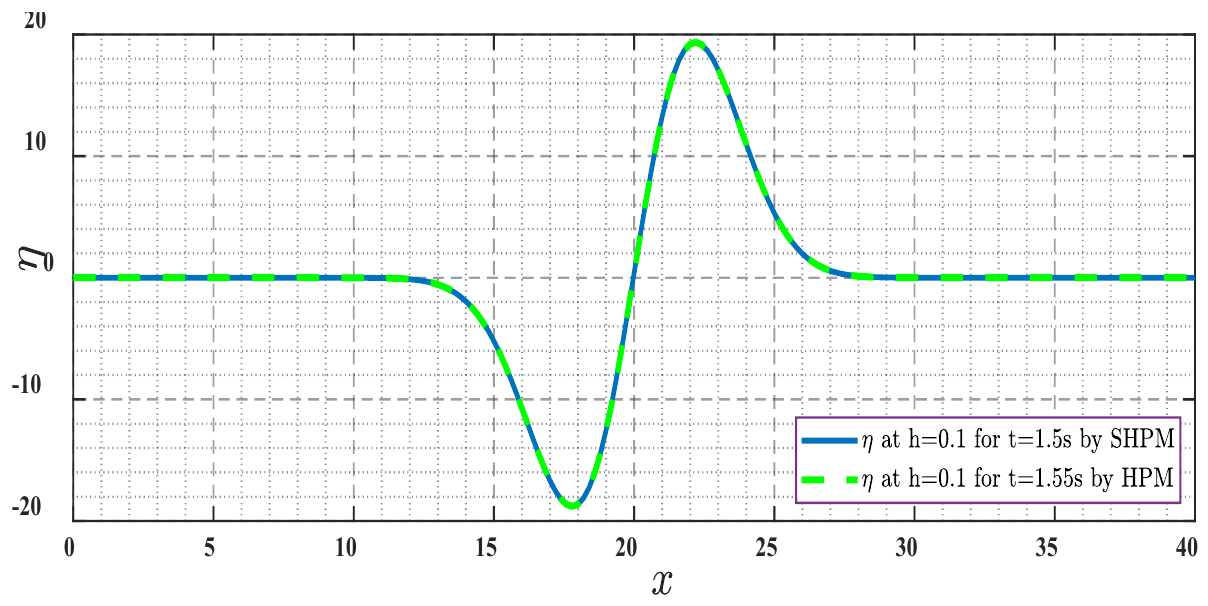
Figure 7. WSE ( η ) by SHPM and HPM at t = 1.5 s ( h =